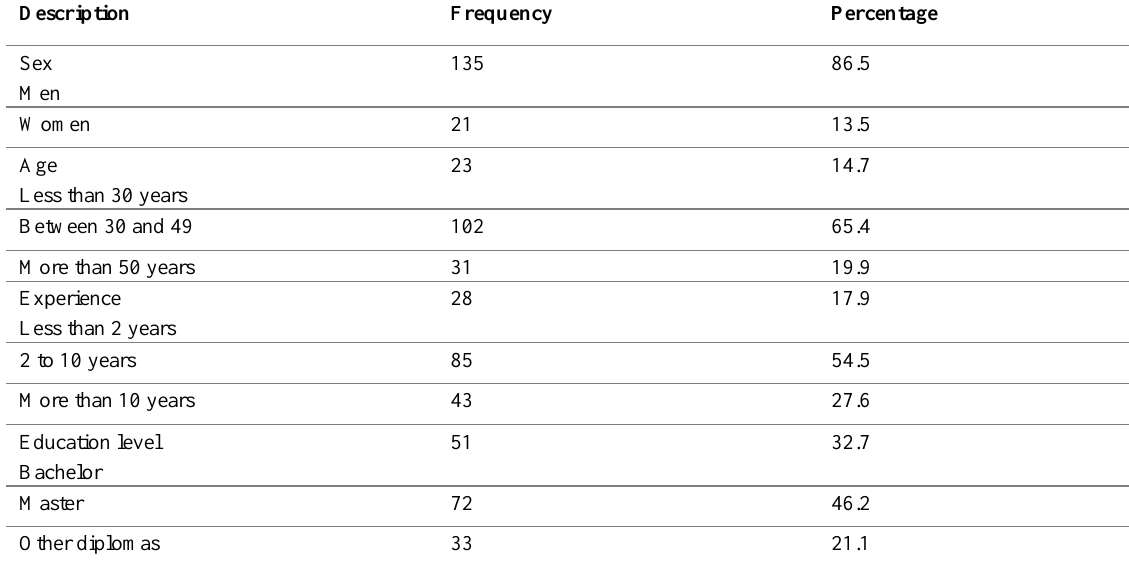
Table 1: Characteristics of